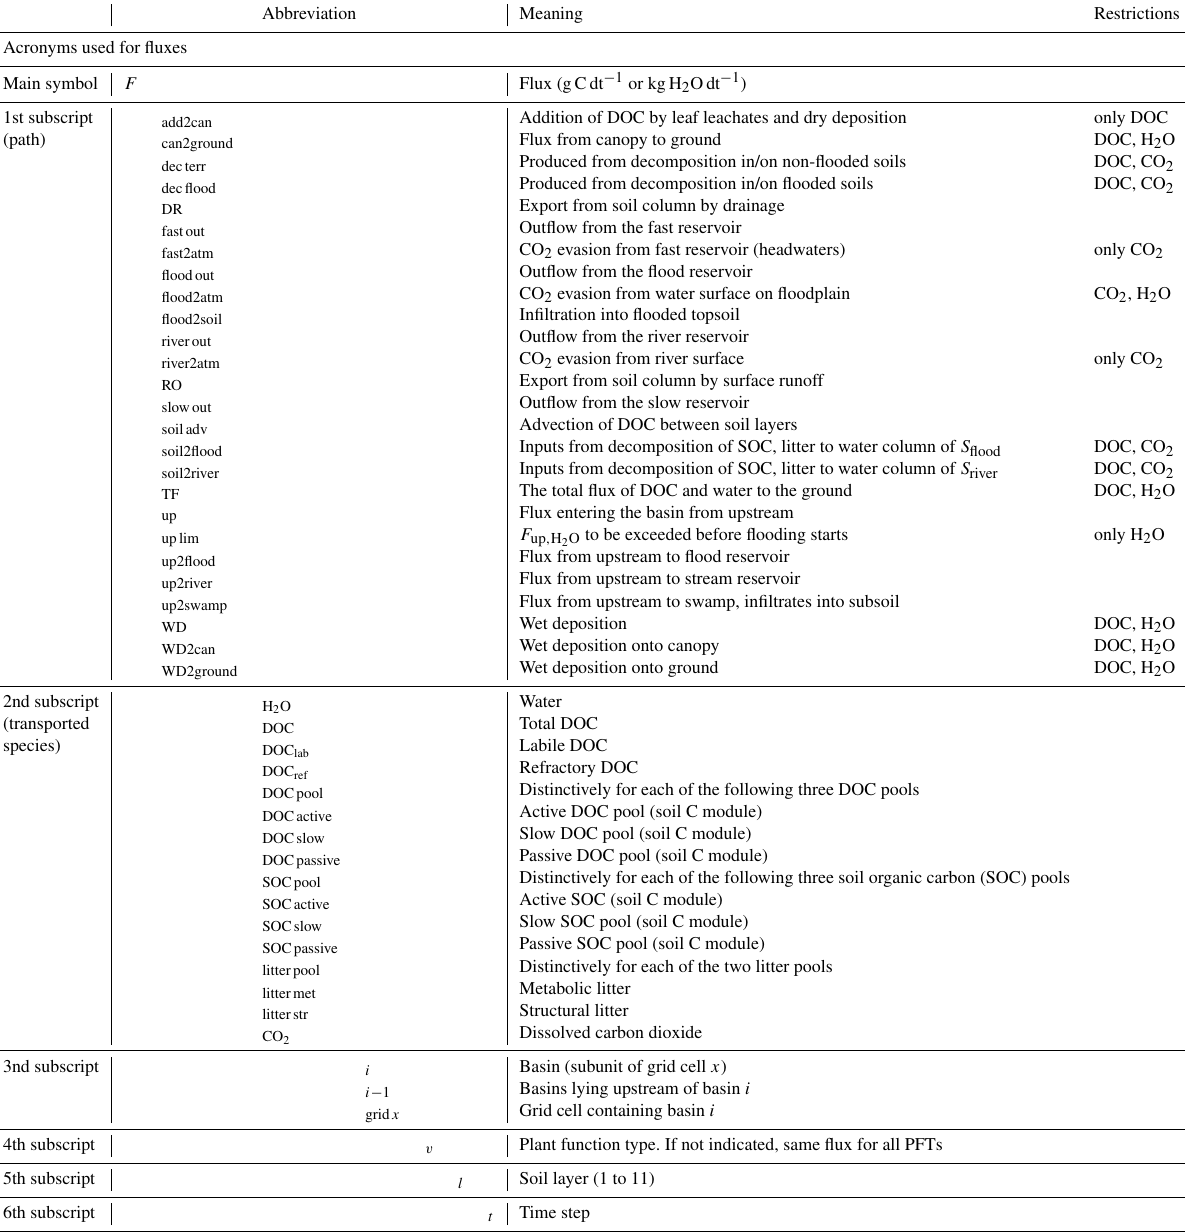
Table A1. Abbreviations used in the